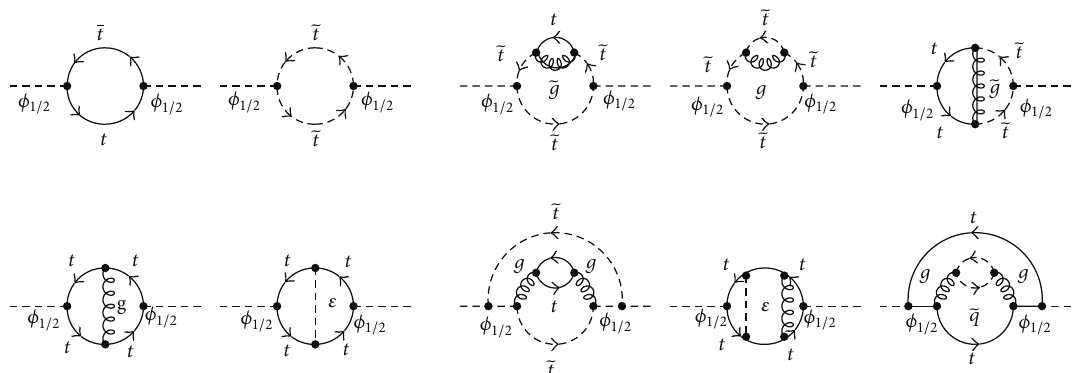
Figure 13: Sample diagrams contributing to Σ 𝜙 lines correspond to top quarks, top squarks, 𝜀 -scalar, and gluons, respectively. Gluinos are depicted with curly lines with an additional solid line in the middle. The external dashed line corresponds to the Higgs bosons.